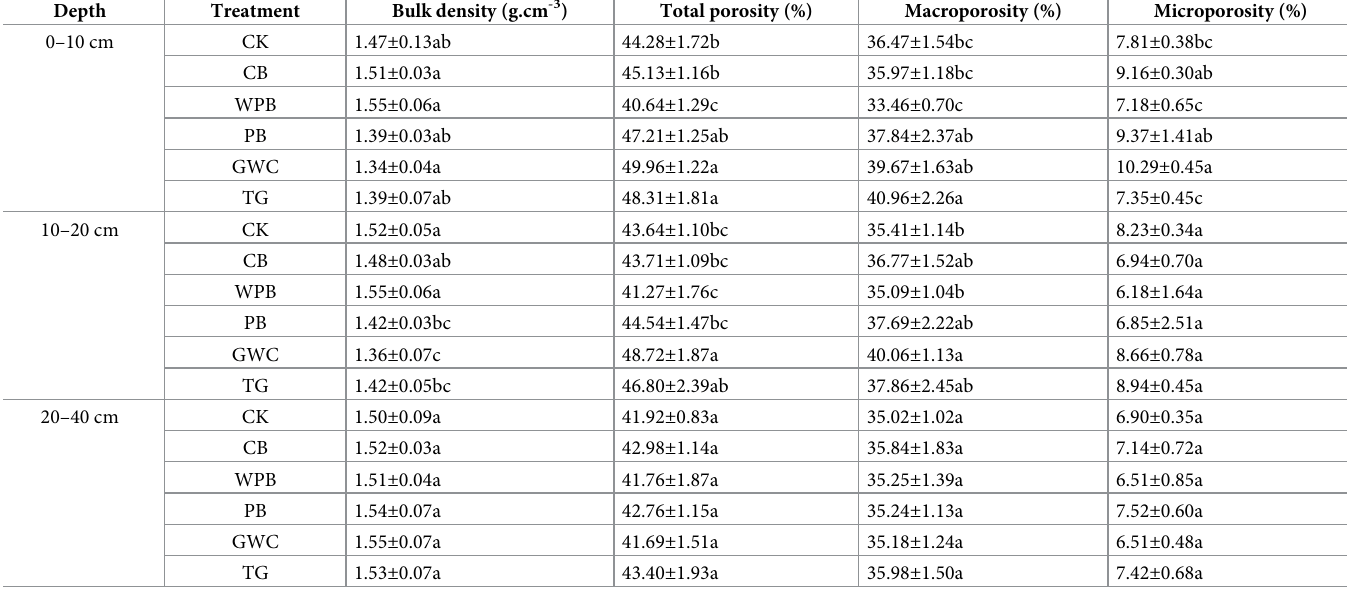
Values with different letters in the same column indicate significant differences between treatments ( p < 0.05, n = 3). Data are means ± standard deviation. https://doi.org/10.1371/journal.pone.0210777.t003 PLOS ONE | https://doi.org/10.1371/journal.pone.0210777 February 6,